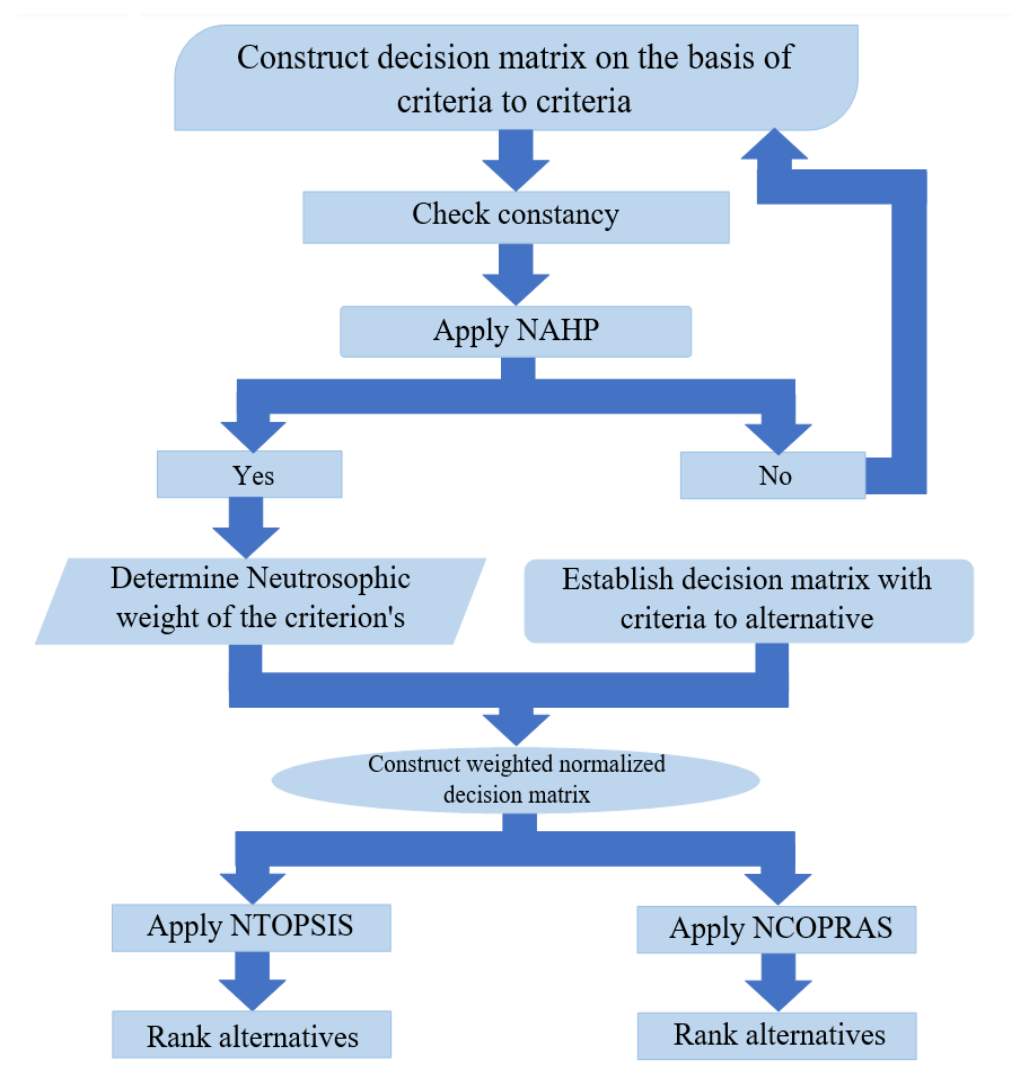
Figure 3. Diagrammatic structure of finding the best site of the women’s university. Now d ijc = { ( α ijc , β ijc , γ ijc , δ ijc ) ; t ijc , i ijc , f ijc } indicate TrNN of i criteria to j criteria as communicate by the DM ‘ c